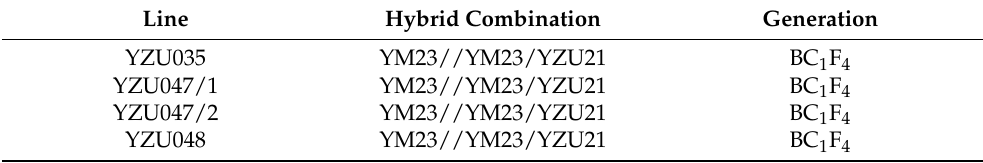
Table 1. The hybrid combination and generation information of new